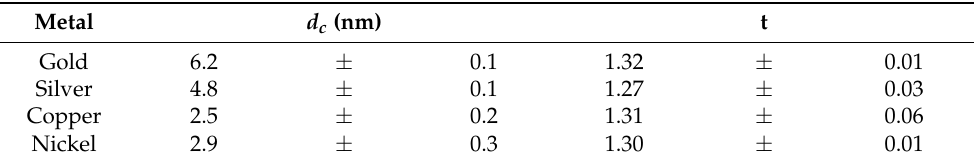
Table 1. Critical thickness of percolation and critical exponents found for in situ resistance measure- ments. Reported values are the average ± the range values of the two respective